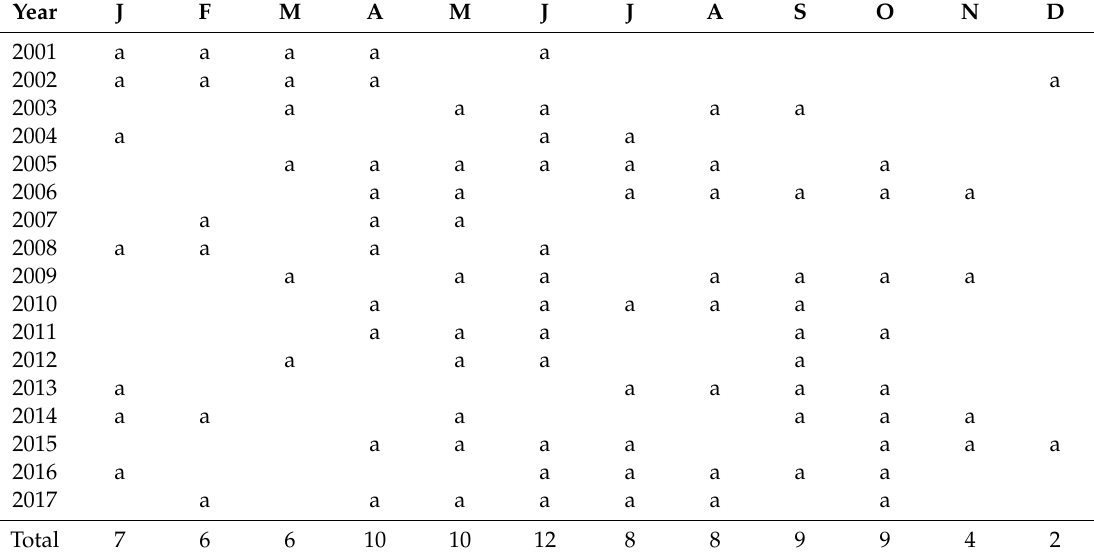
Table 5. Distribution of climatic anomalies by the months of the constituent years of the period under